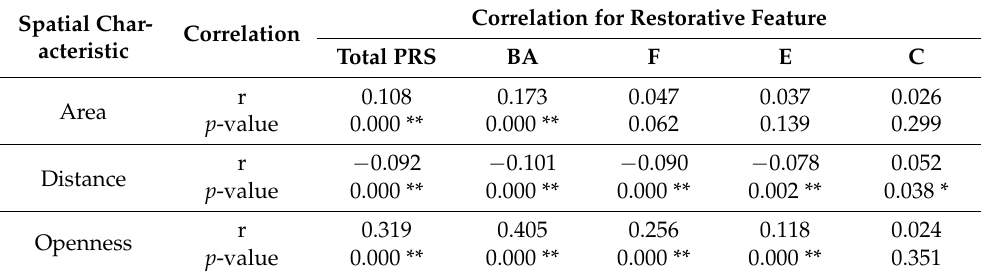
Table 4. Correlation between spatial characteristics and perceived restorativeness. Correlation for Restorative Spatial Char- Correlation acteristic